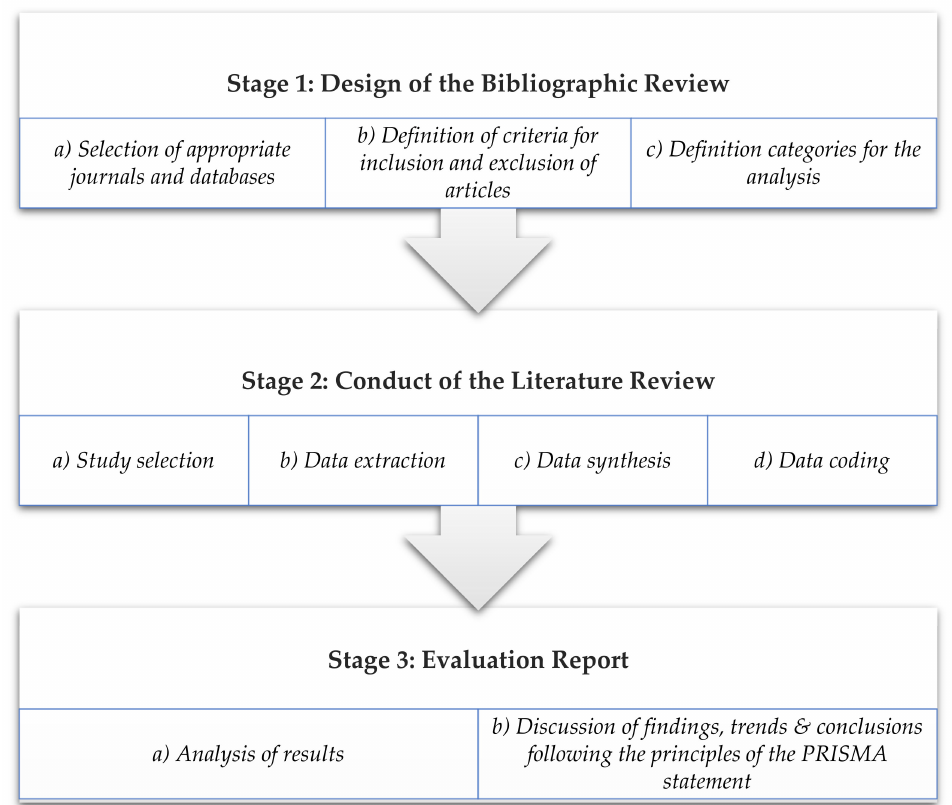
Figure 2. The design stages of the research